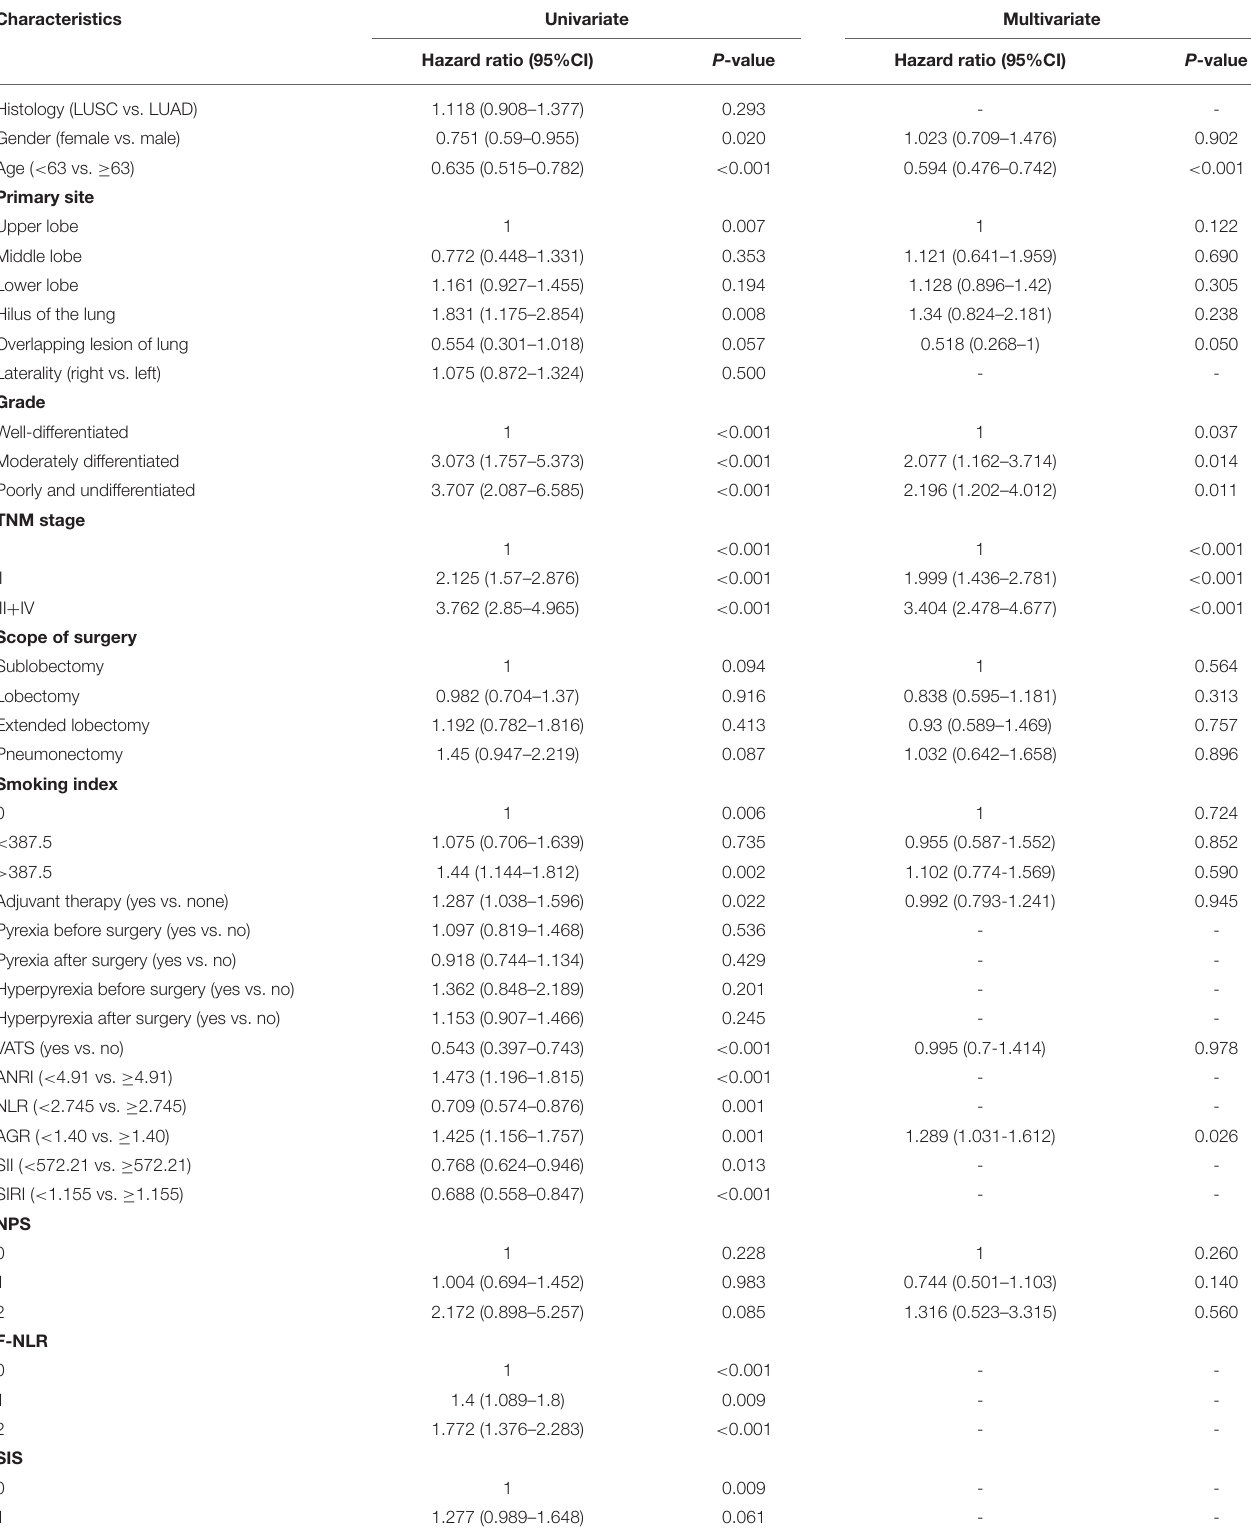
TABLE 2 | Univariate and multivariate COX regression analysis of overall survival in training group.